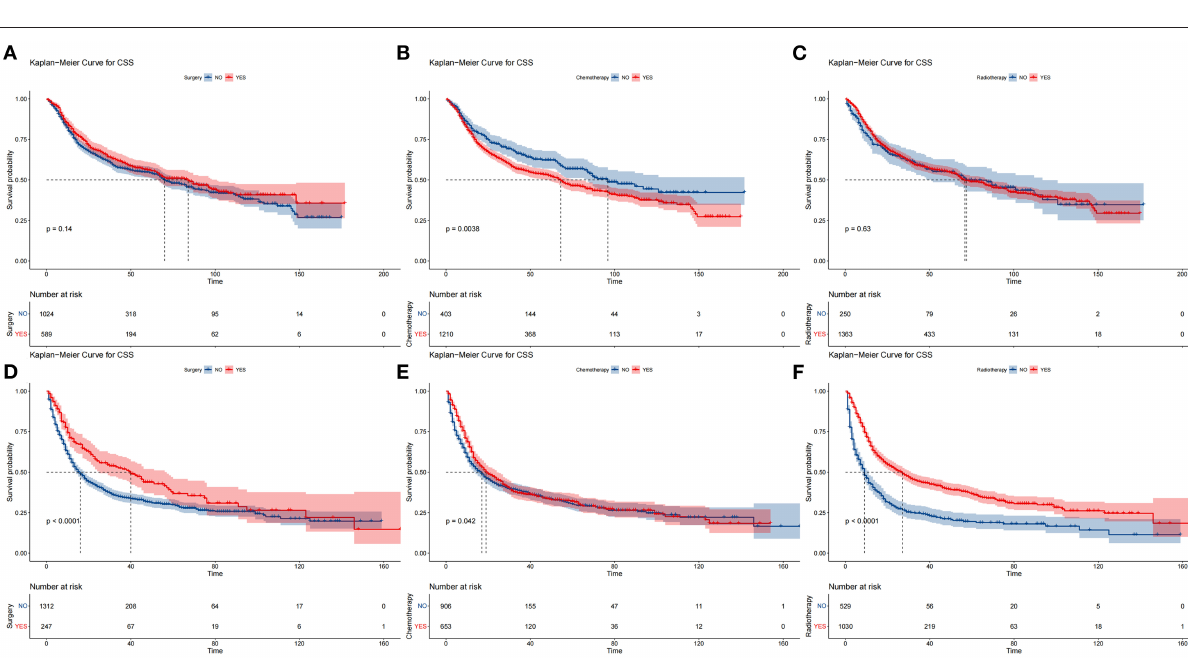
followed up. Then the patients were included in the model for external